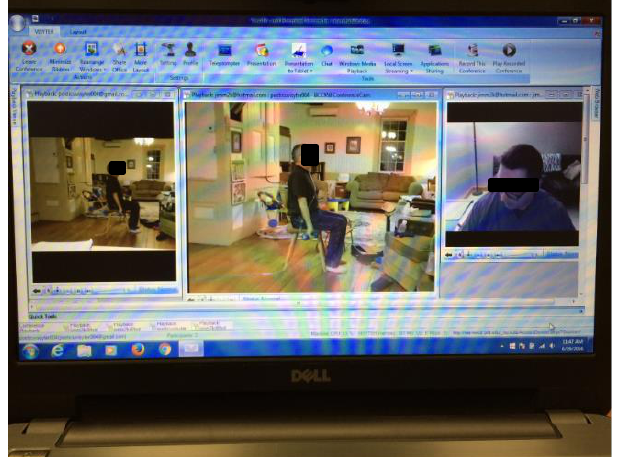
Figure 1. A sample screenshot of an exercise session delivered via